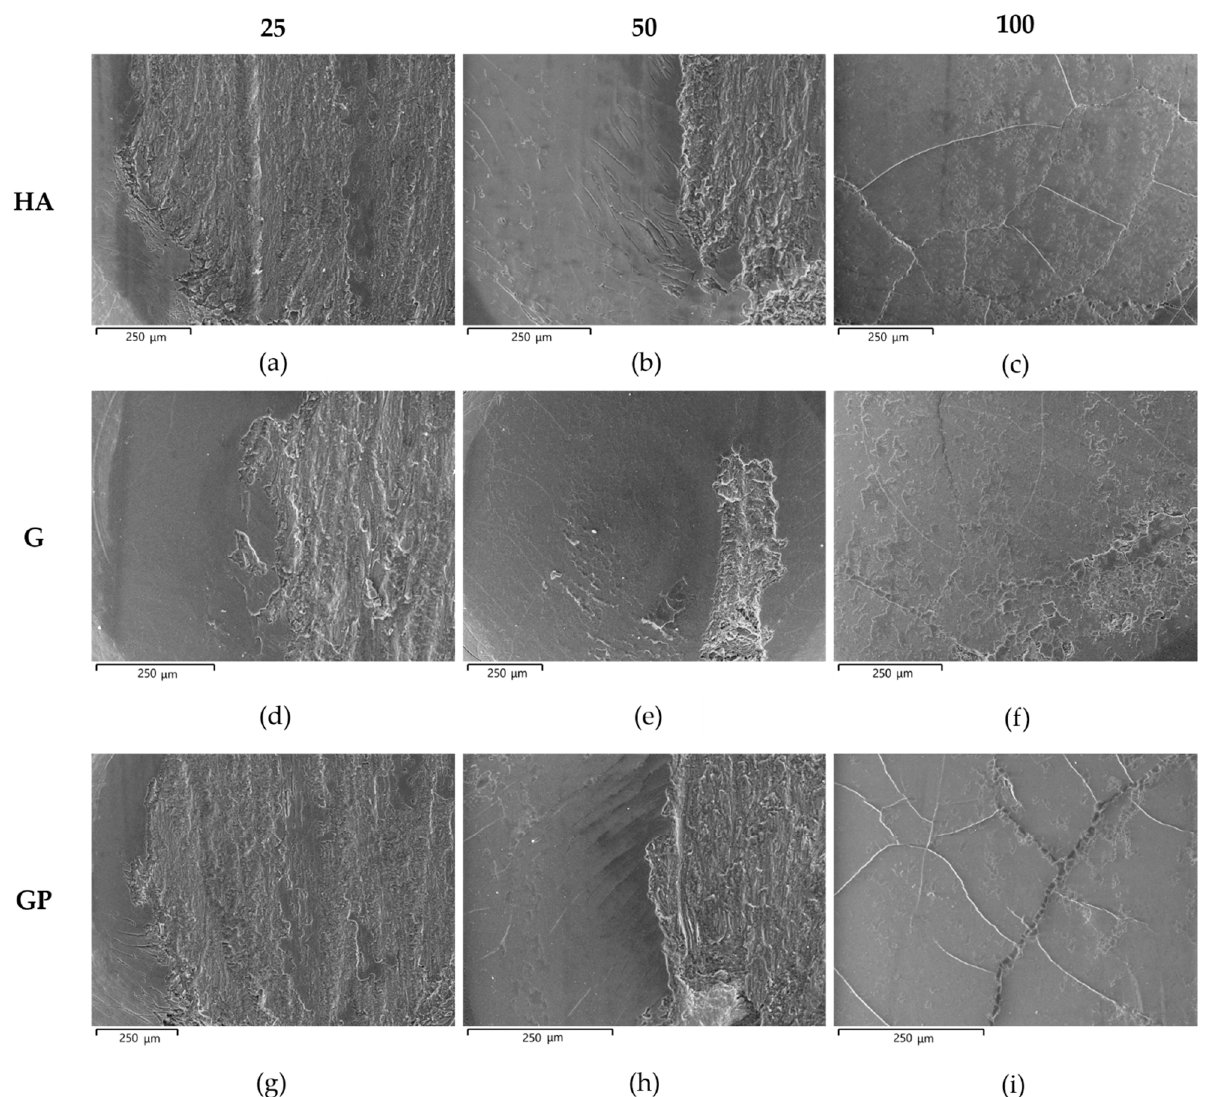
Figure 9. VPSEM images of the worn surface of pins after wear tests: ( a – c ) HA-, ( d – f ) G-, and ( g – i ) GP-treated surfaces with all thicknesses examined.